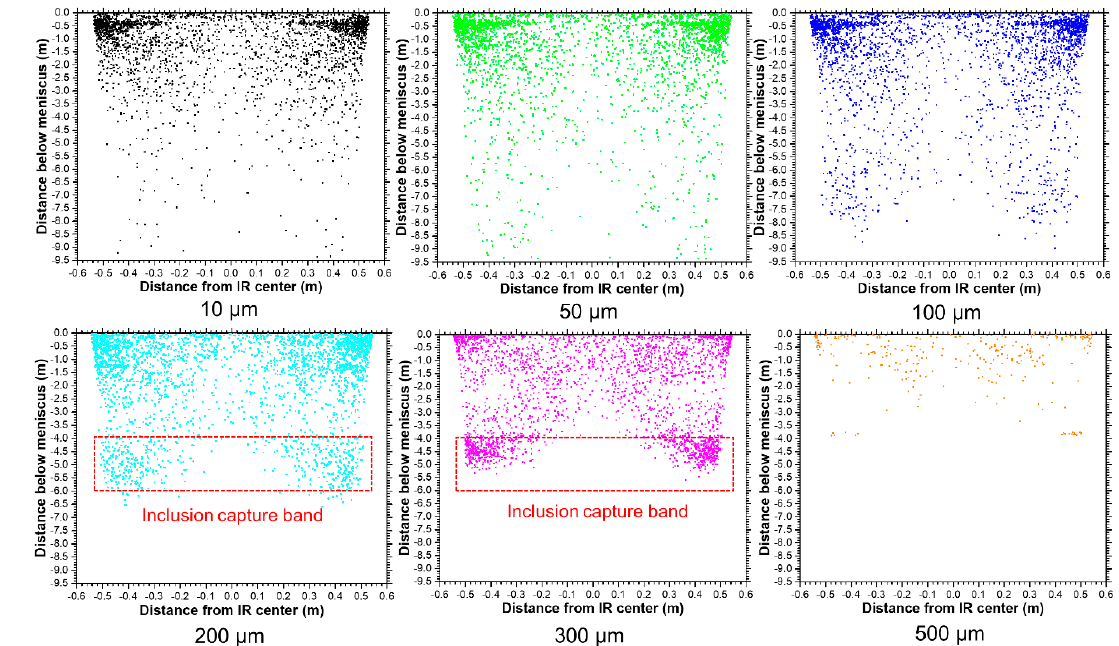
Figure 7. Inclusion capture locations on the IR shell, by inclusion size (front view).